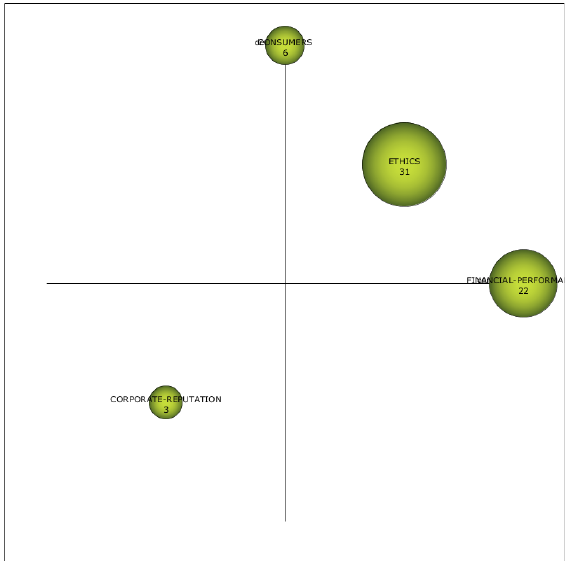
Figure 6. Strategic diagram for the 2007–2010